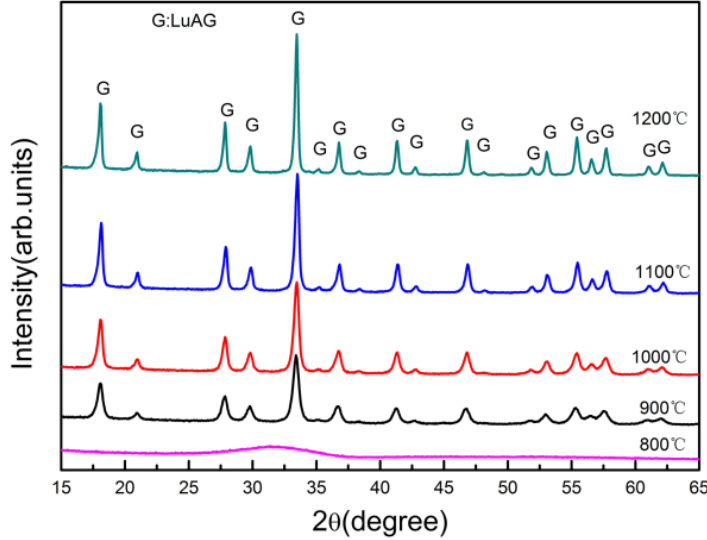
Figure 3. XRD patterns of S7 calcined at different temperatures for 3 h.